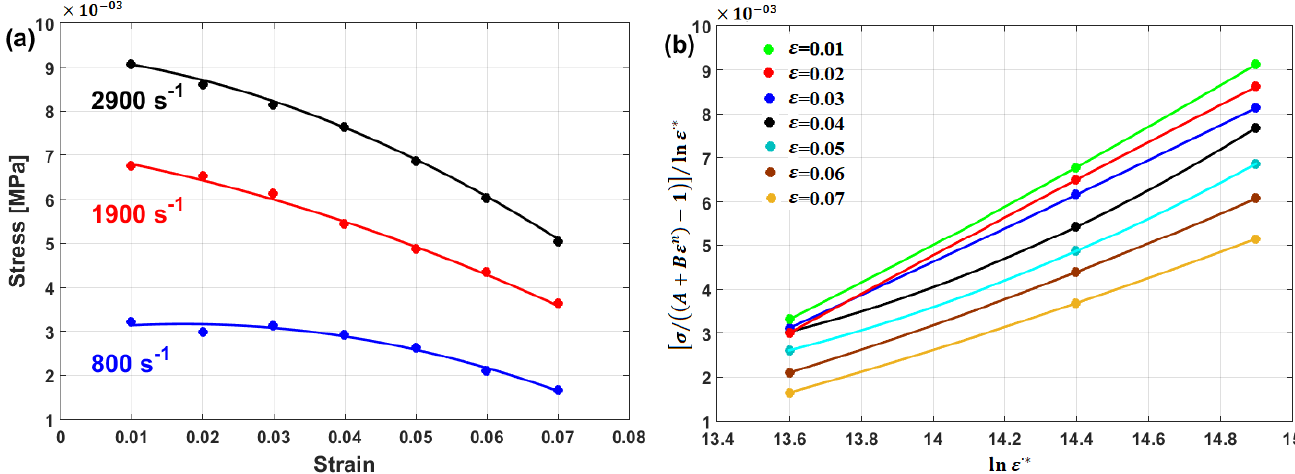
Figure 29. Determination of C ( ε , ε · ) ( a ) C vs. ε and ( b ) C vs. ε · . Constant C ( ε , ε · ) is determined by Tan et al. [53] as: